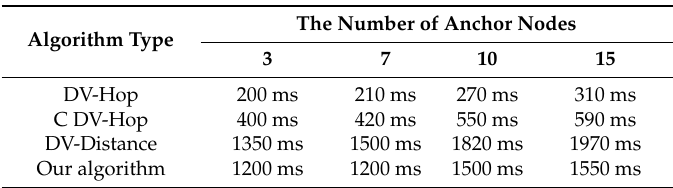
Table 1. Effect factors of localization time (case 1).